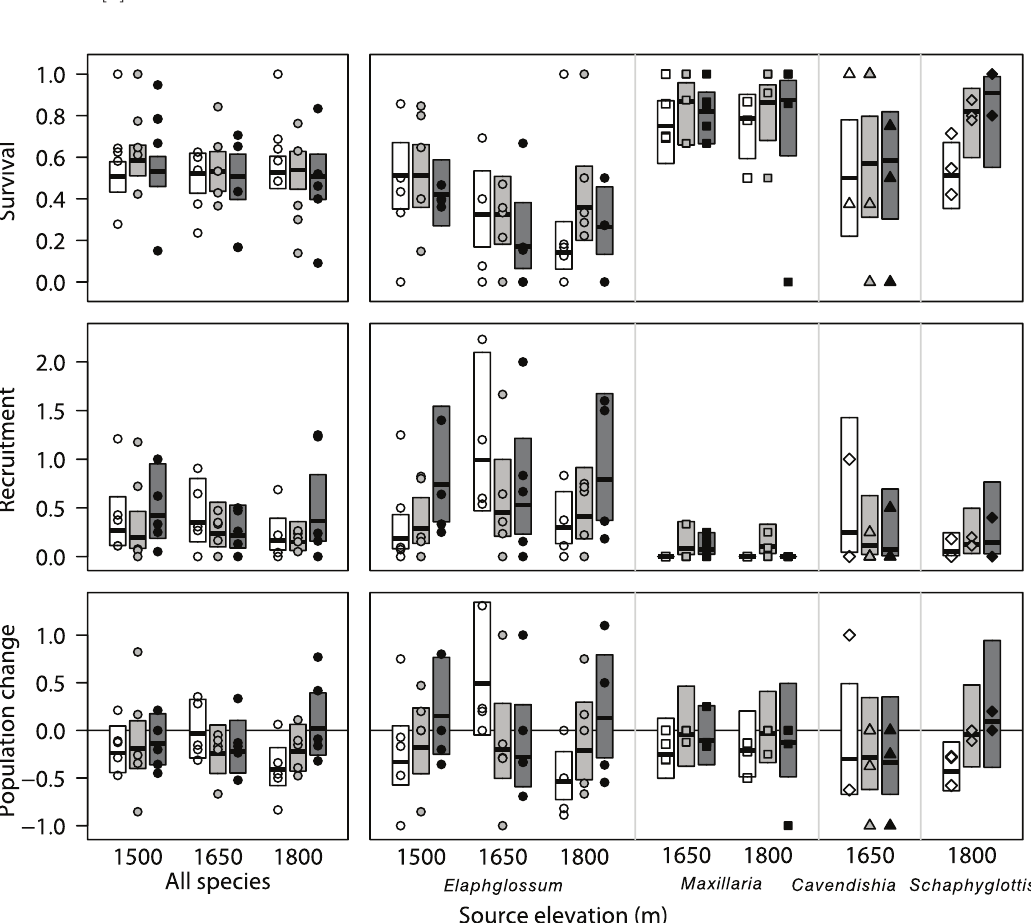
Figure 2. Survival, recruitment, and population change of epiphyte ramets from a reciprocal transplant experiment across three elevations. Points show survival (top), recruitment (middle), and population change (bottom) of individual mats in 2006, each expressed as a proportion relative to the number of ramets present in 2005. Thick horizontal lines and boxes depict the modeled mean and 95% confidence intervals, respectively. White shading depicts 1500 m elevation, light grey 1650 m elevation and dark grey 1800 m